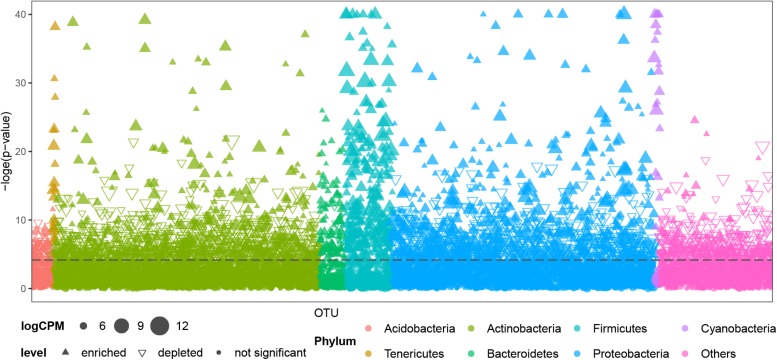
Comparison of OTUs’ distribution between air samples and other samples (niches) from caves. CPM is counts per million, the dashed line is the 95% confidence level. Solid upward triangles are OTUs significantly enriched in air samples, hollow downward triangles are OTUs significantly depleted in air samples, solid points are those OTUs significantly unchanged in air samples compared with other types of samples. The size of triangles and points are proportional to the abundance of that OTU.